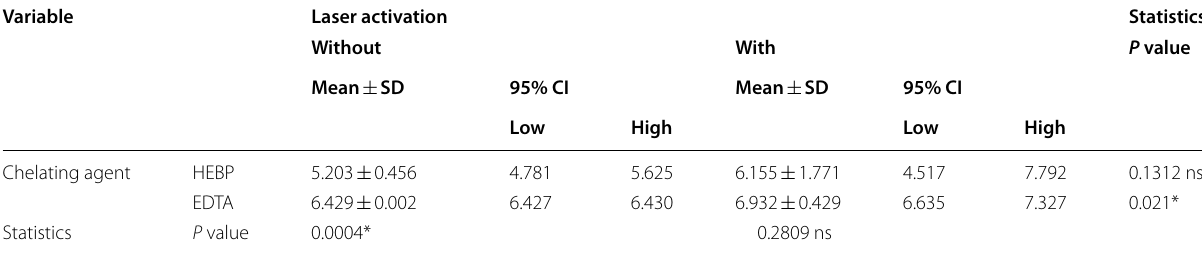
SDs) as function of chelating agent group type and laser activation ±